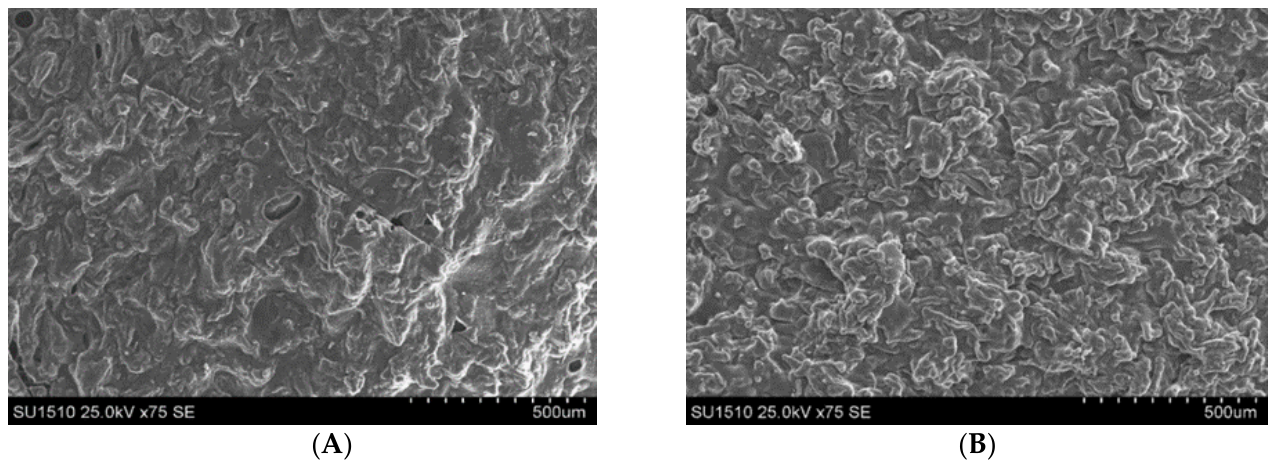
Figure 7. SEM micrographs—comparison of the morphology of IPNc ( A ) and IPNb ( B ). However, the use of a larger amount of HEMA (accompanied by HDDA)—in a propor- tion of 200%, compared to cellulose—led to a much more crosslinked structure (IPNb) as a whole. This effect was due to the greater amount of the HEMA-based network that interpen- etrated the polysaccharide network. Its morphology was more compact, compared to